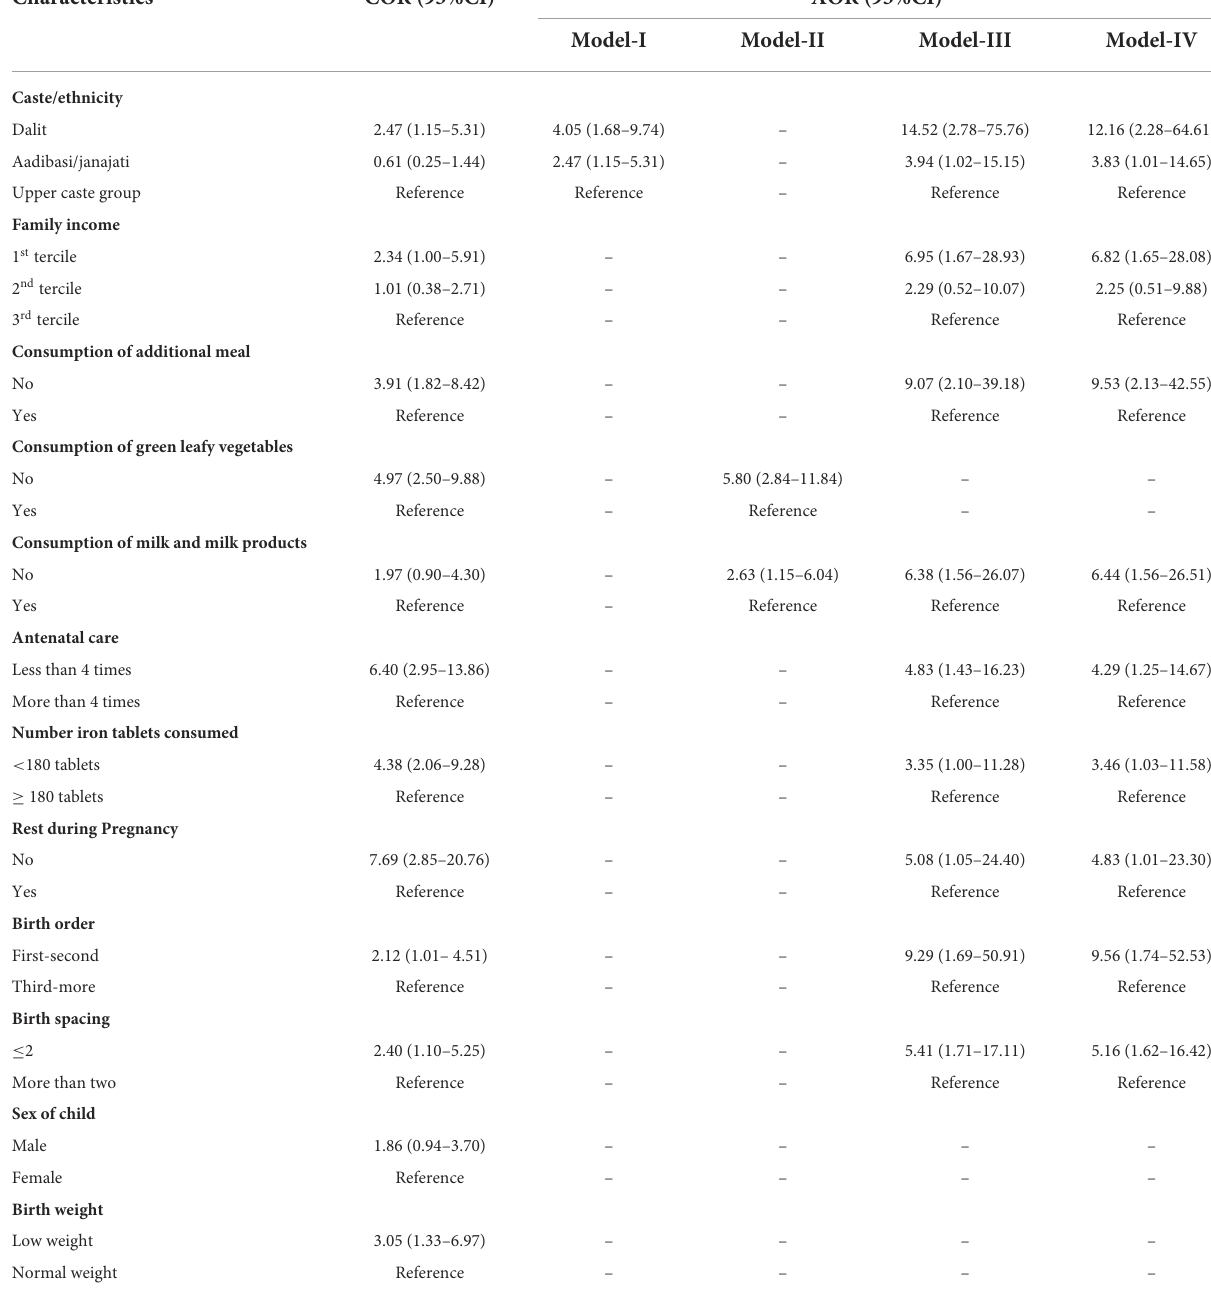
TABLE 4 Factors associated with pre-term delivery by multilevel logistic regression